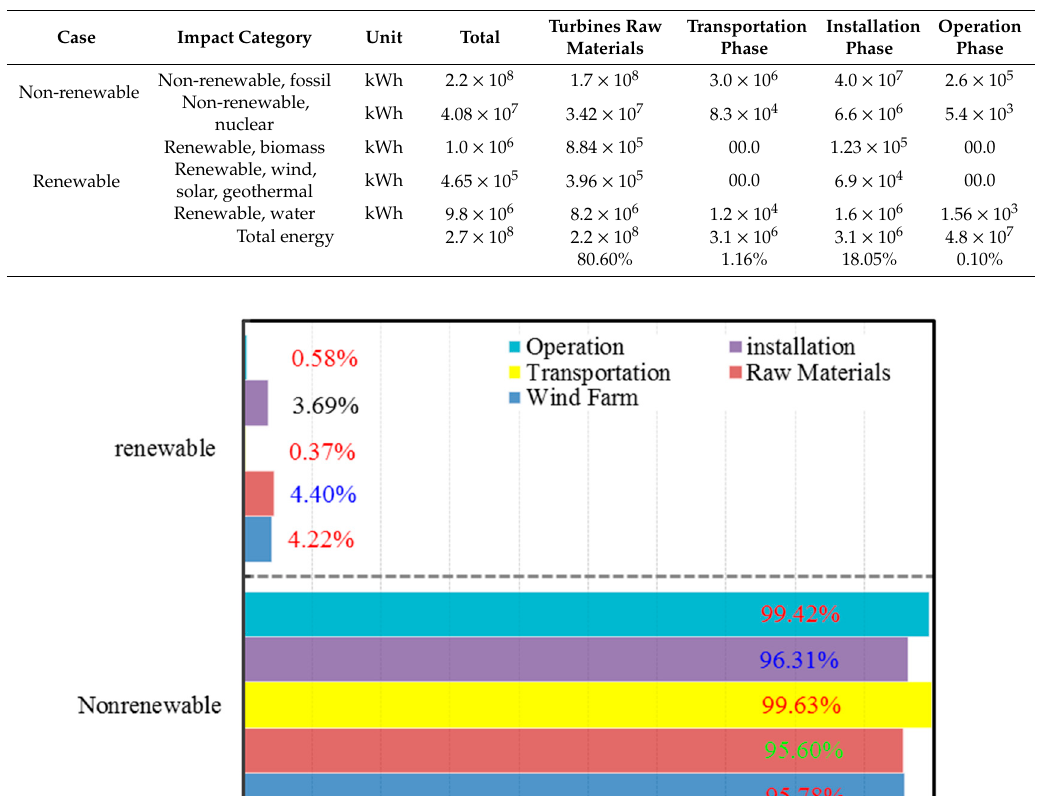
Table 14. The cumulative energy demand (38 turbines) of each phase for each type of energy for a 20-year lifespan.